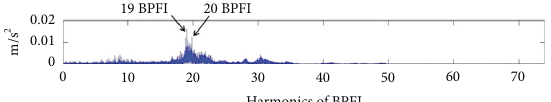
Figure 6: Defect on the inner race: channel 2, 1st OIMF, referred to the